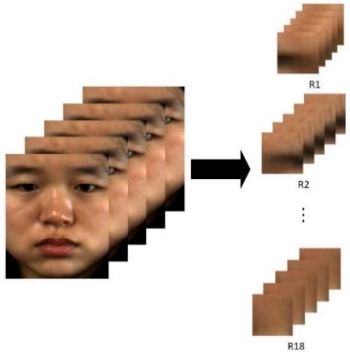
Figure 6. Active facial patches of micro-expression sequence.